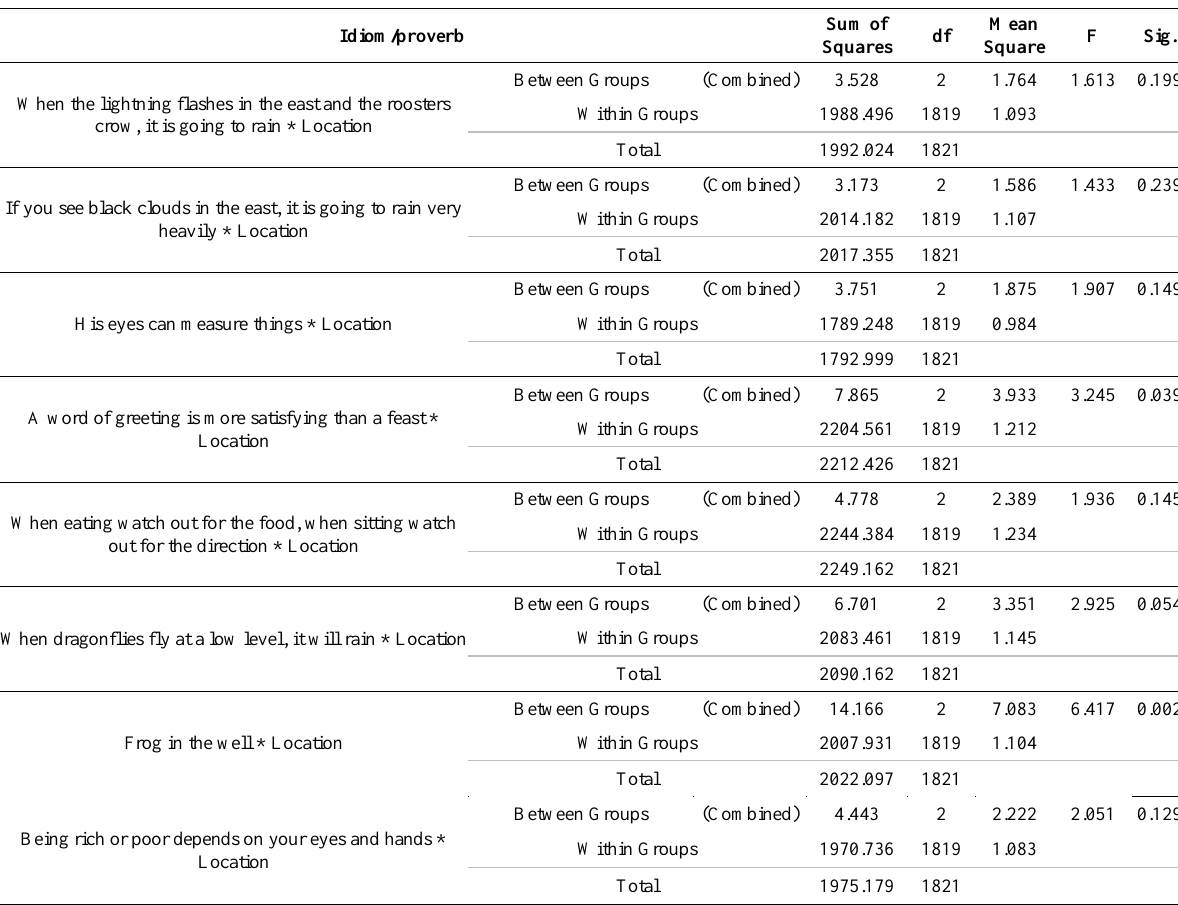
Table 4. Results of ANOVA test on the mean scores among the three locations (Mountainous, Rural, Urban)